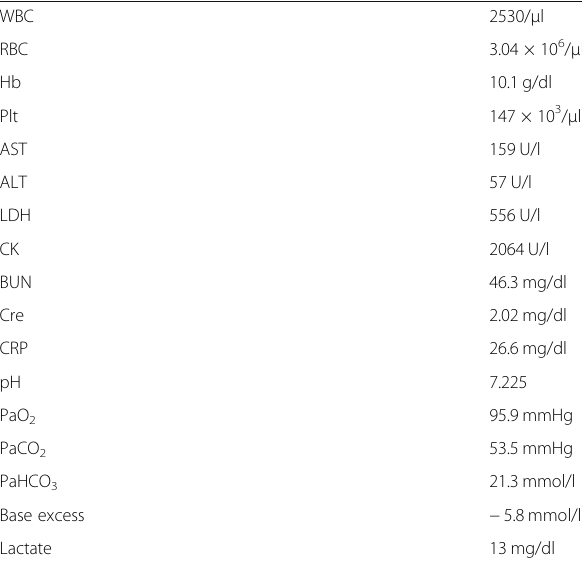
Table 1 Laboratory findings and arterial blood gas findings on postoperative day 2 after esophagectomy